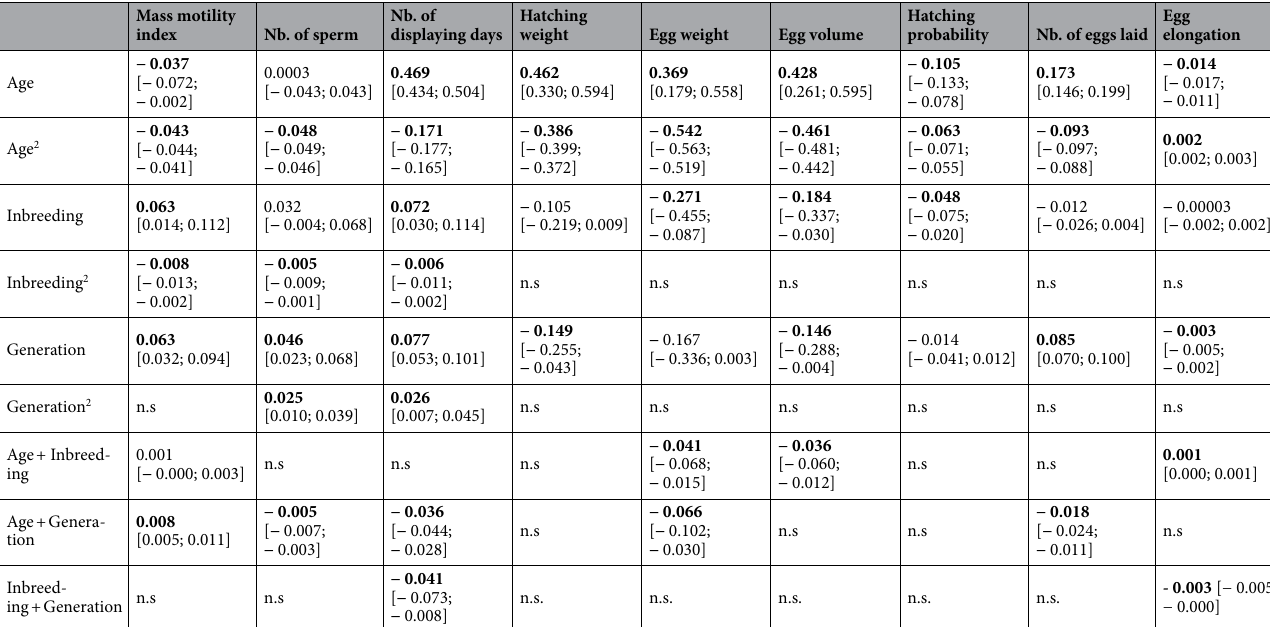
Table 3. Estimate values (i.e., slopes of the regression) and 95% confidence intervals of the effect of the three main explanatory variables (age, inbreeding and number of generations in captivity), their quadratic terms and interactions. Estimates in bold indicate significance ( p value < 0.05) while estimates of variables which effect was not significant and removed during model selection are not indicated (“n.s.”). More detailed results of models can be found in Supplementary Table S2, S3 online.